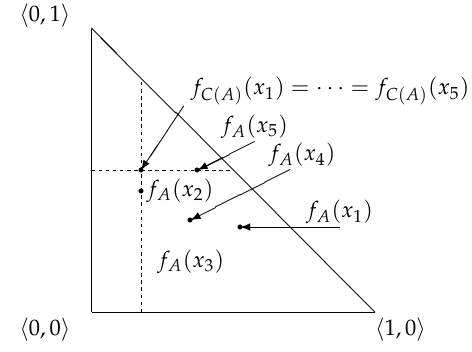
Figure 4. Geometrical interpretation of operator I